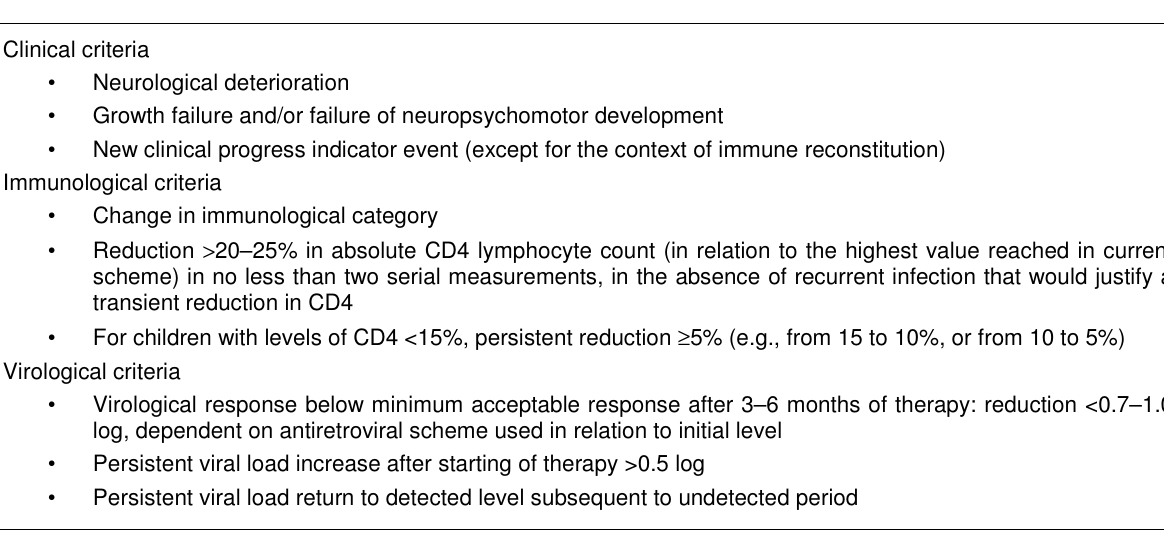
Therapy Failure